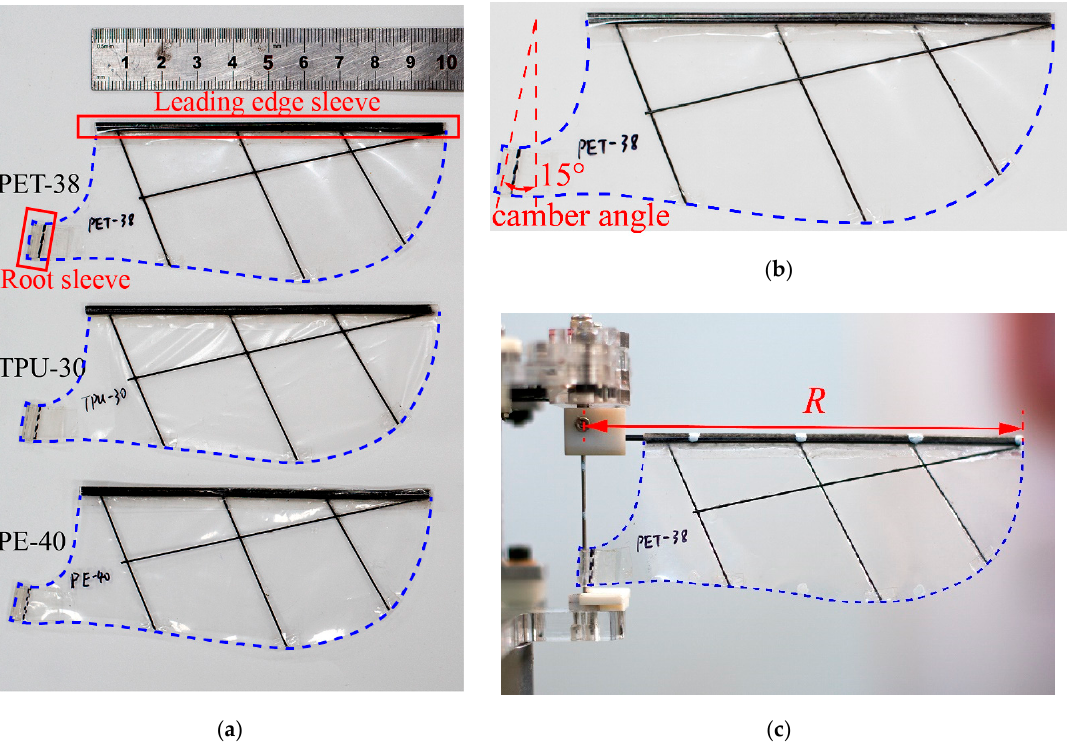
Figure 3. Wings designed for the test. ( a ) Photograph of three wings; ( b ) Description of the camber angle; ( c ) Wing assembled on the mechanism. Table 1. Material properties of the tested Wings .